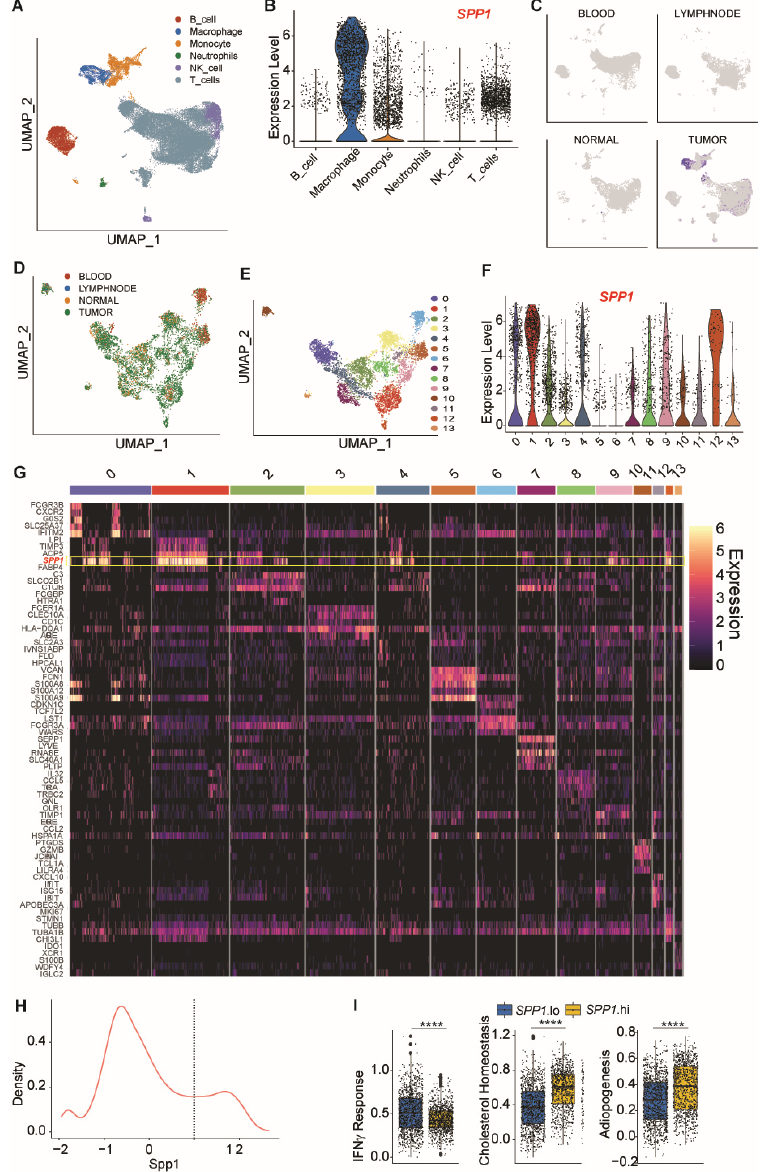
Figure 3. Analysis of OPN expression profiles in cells of the human breast tumor microenvironment in single-cell level. Datasets were extracted from the human breast tumor single-cell RNA-Seq datasets (GEO accession: GSE114727) and analyzed using R package. ( A ) UMAP projection of GSE114725 scRNA-seq data. Cluster identities were determined by comparison to Human Protein Atlas reference samples by SingleR. ( B ) Expression of SPP1 in indicated cell clusters. ( C ) UMAP projection of SP1 expression, with cells sub-grouped by tissue of origin. ( D ) Sub-grouping and re-clustering of myeloid (macrophage, monocyte and neutrophil) cell populations. Cells labeled by tissue of origin. ( E ) UMAP projection of myeloid cells, labeled by k-means cluster identity. ( F ) SPP1 expression in indicated cell clusters. ( G ) Heatmap of top 5 differentially expressed markers by